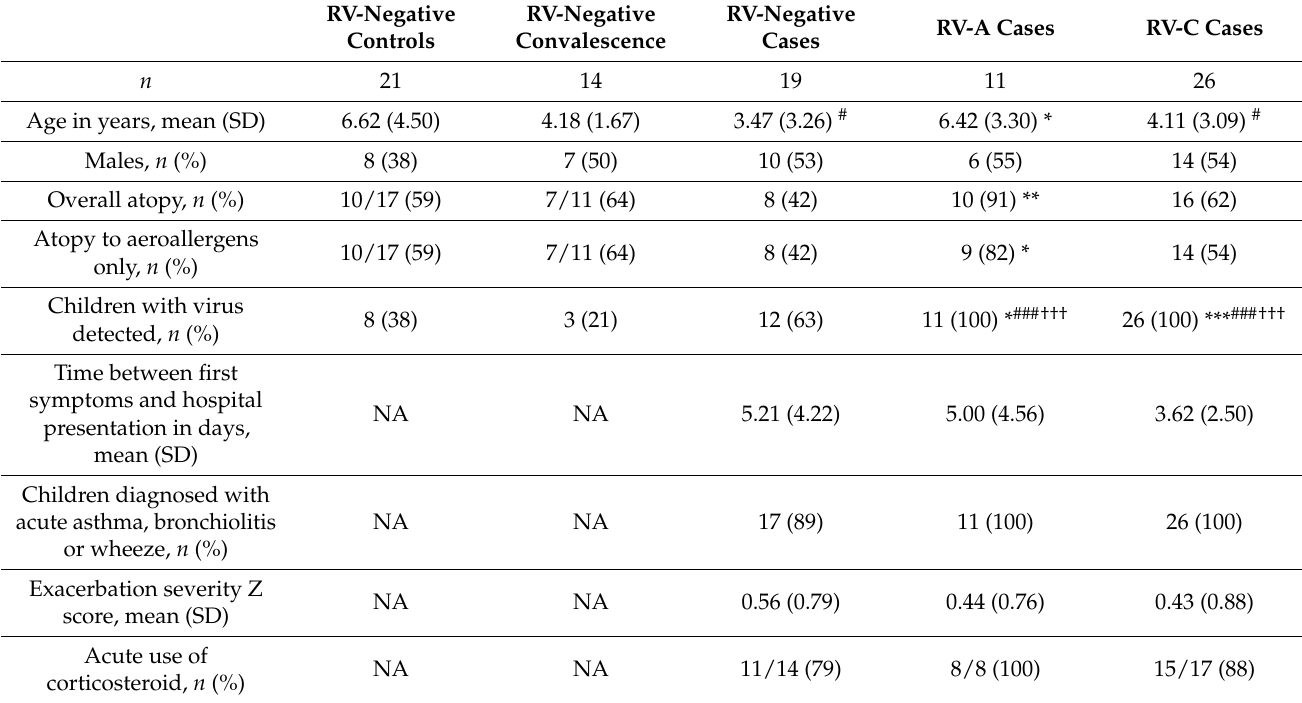
Table 1. Characteristics of the study population used for microarray analysis of gene expression. RV-Negative RV-Negative RV-Negative RV-A Cases RV-C Cases Controls Convalescence Cases 21